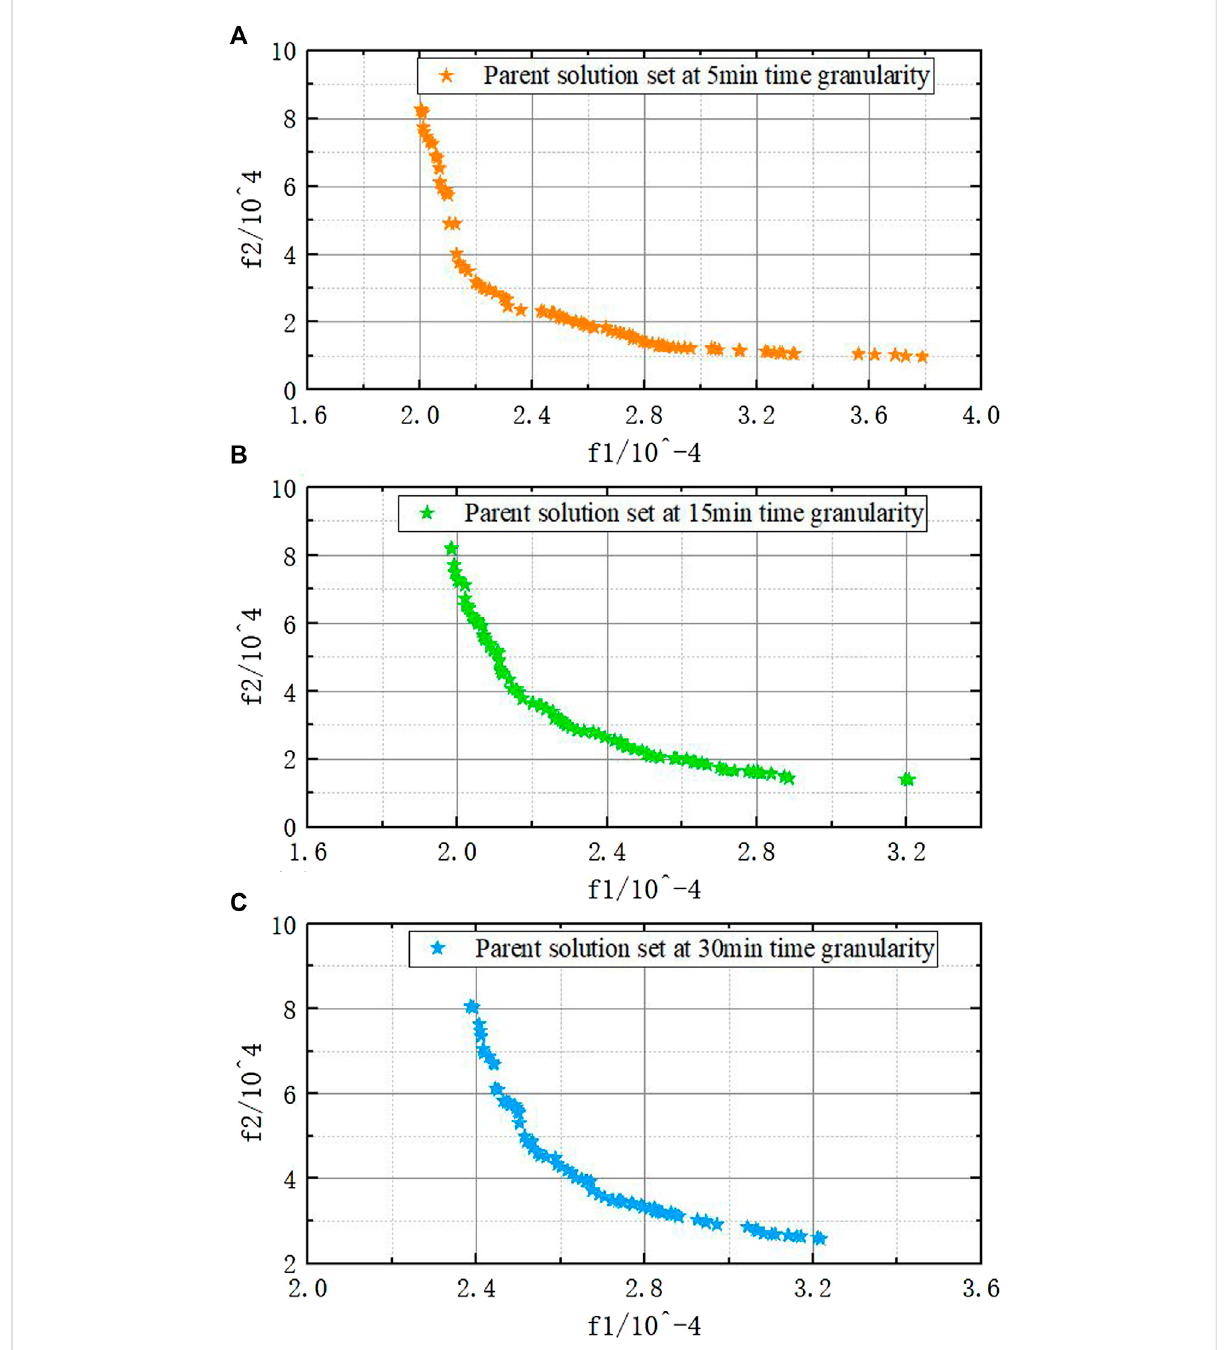
FIGURE 12 Pareto solution set under different time granularities. (A) Pareto solution set at 5 min time granularity; (B) Pareto solution set at 15 min time granularity; (C) Pareto solution set at 30 min time